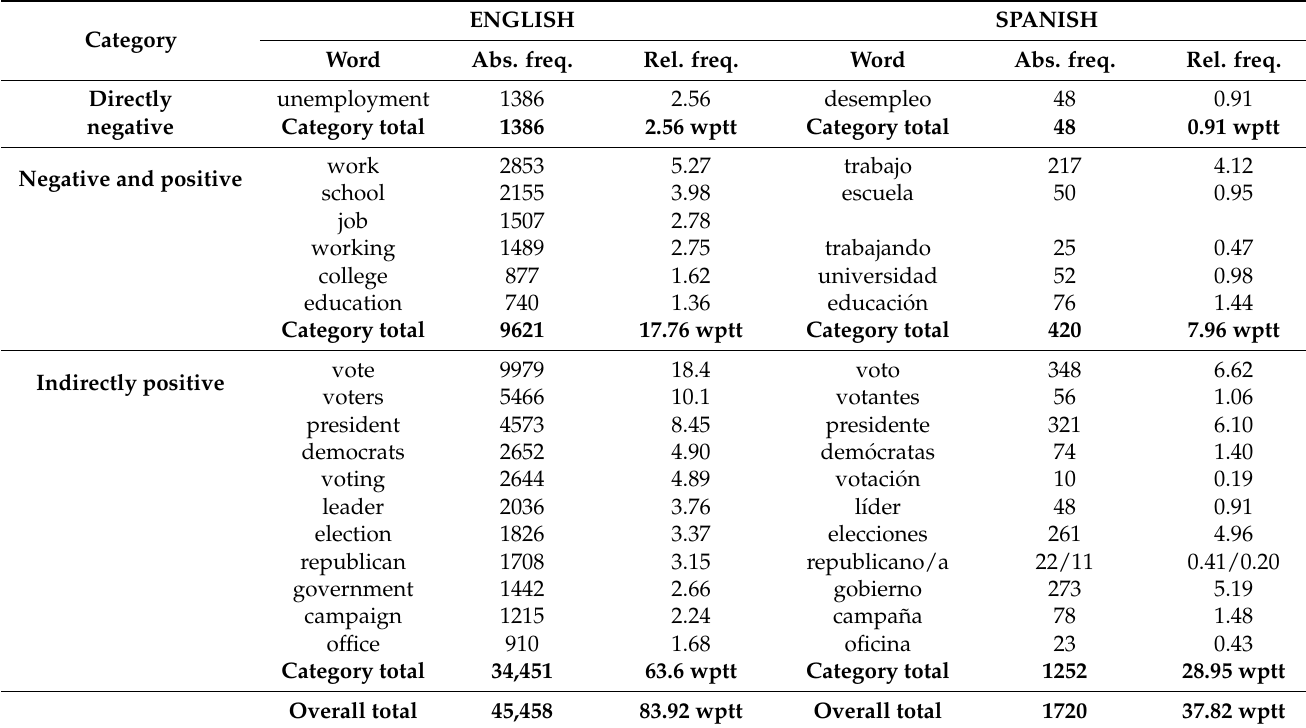
Table 1. Absolute and relative frequencies of status-related descriptors in the English and the Spanish corpus. ENGLISH SPANISH Category Word Abs. freq. Rel. freq. Abs. freq. Rel. freq.